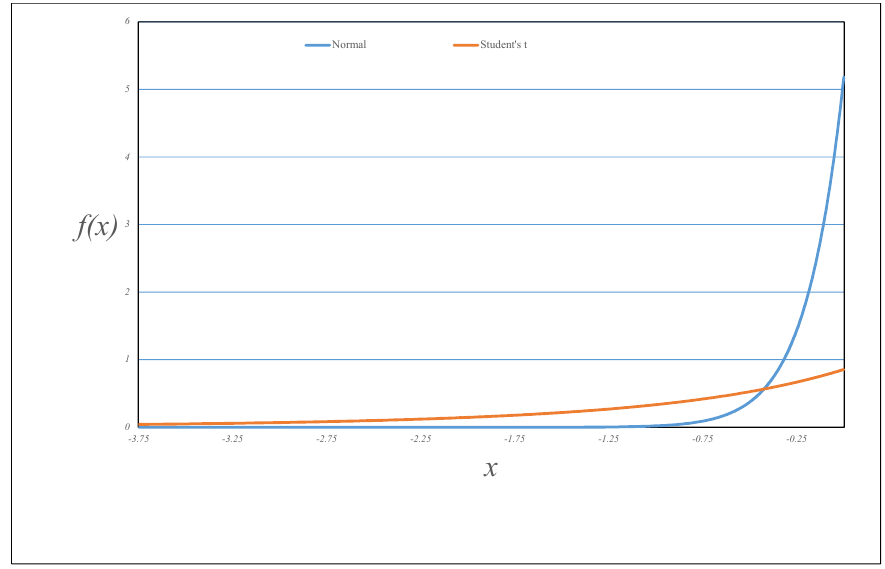
Figure 12. Comparison of the conditional distribution of standardized market